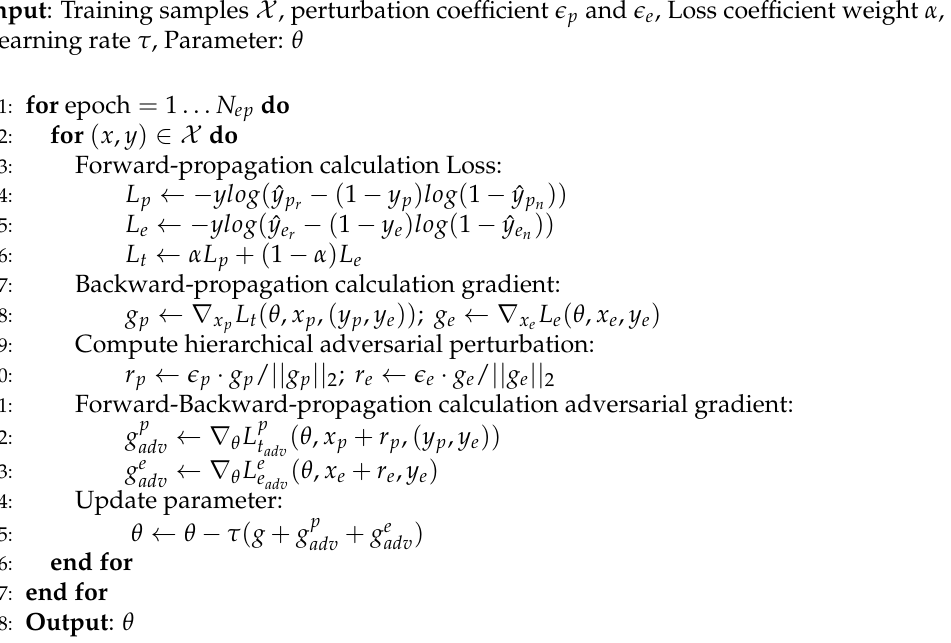
Algorithm 1 Hierarchical adversarial training